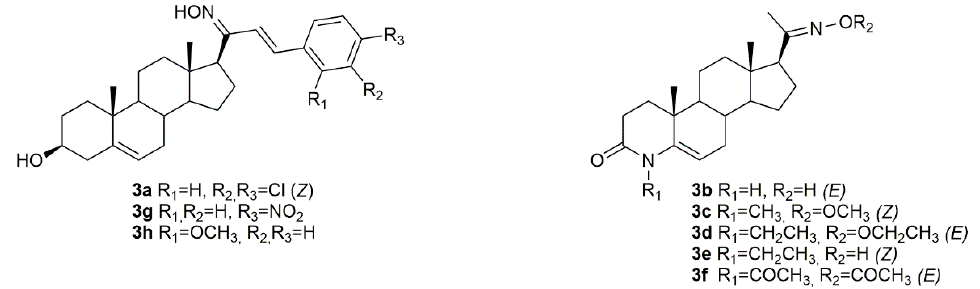
Figure 6. Steroidal pregnane oxime derivatives with antitumor activity in several types of cancer cells.